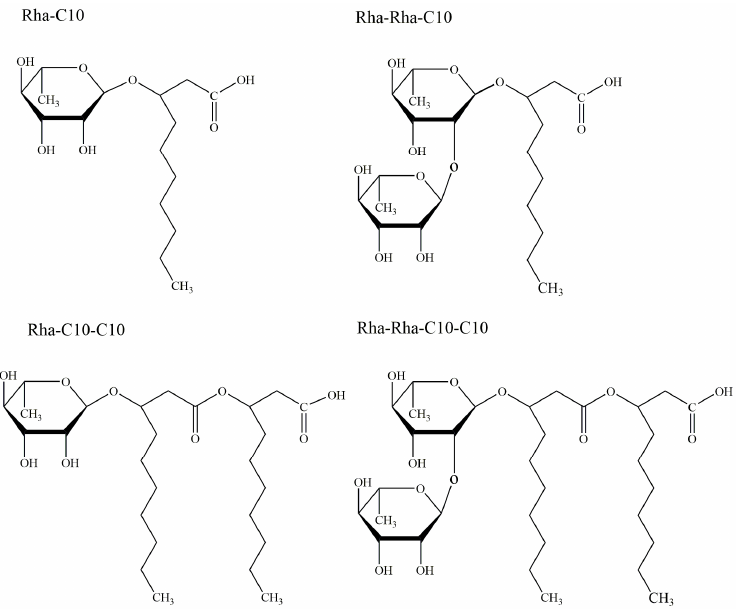
Figure 2. Common structures of rhamnolipids produced by Pseudomonas species . Table 1. Antimicrobial effects of rhamnolipids reported to date.